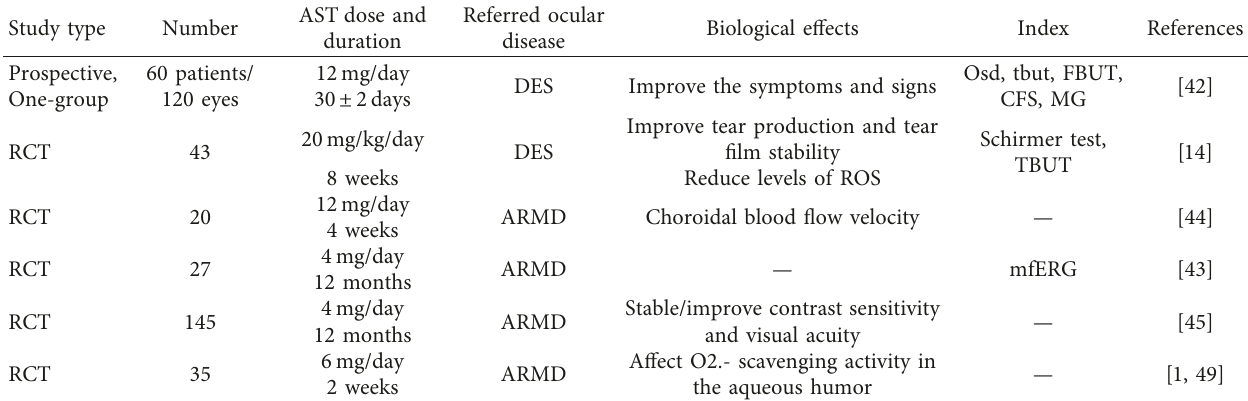
Table 1: Summary of in clinical studies on eye and